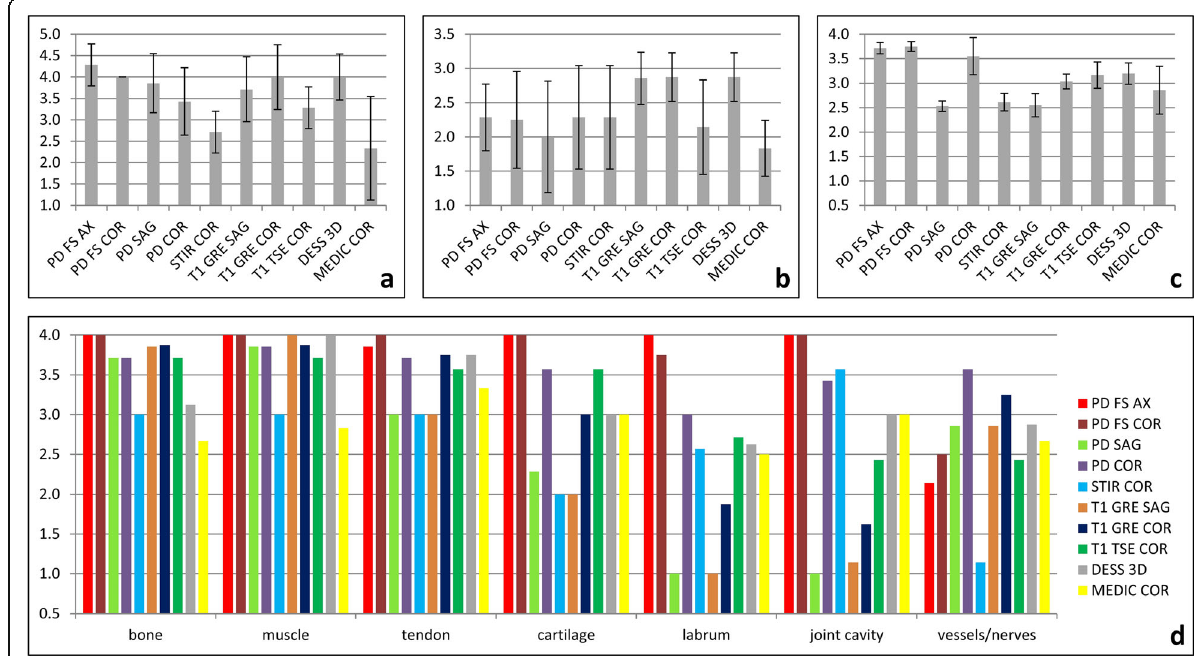
Fig. 1 Image quality of 7-T shoulder MRI. The amount of artifacts ( a ), the intensity of B 1+ inhomogeneities ( b ), and the structure assessability in detail for each structure ( d ) as well as averaged over all structures ( c ) is displayed for each